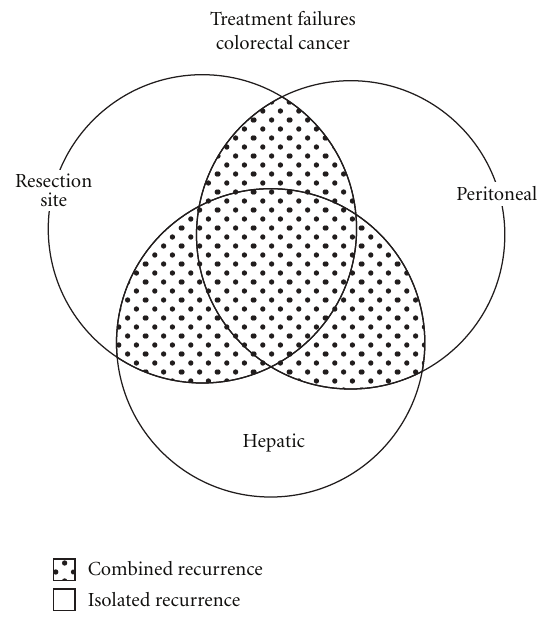
Figure 1: Ring diagram shows that hematogenous metastases and cancer seeding can occur in isolation or in combination with other sites of surgical treatment failure. High-density seeding at the resection site causes a layering of cancer; low-density seeding at a distance results in peritoneal carcinomatosis (reprinted from [18] with